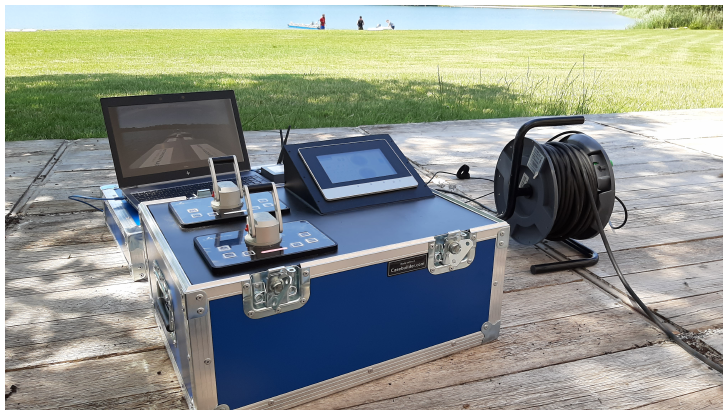
Figure 18. Moveable motion control subsystem of the I-SCC system, deployed at Rotselaar